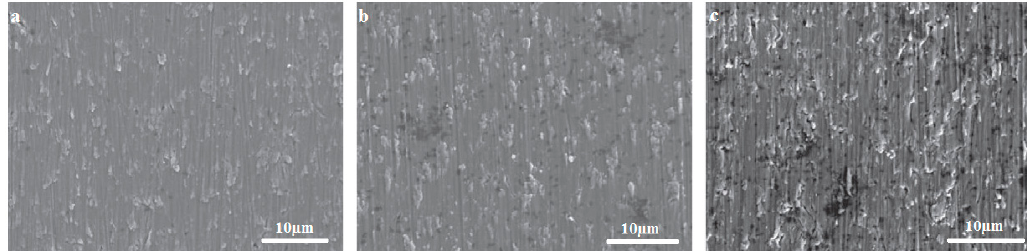
Figure 1. Scanning electron microscope (SEM) images of Ti-24Nb-4Zr-8Sn alloy after immersion in 0.9% NaCl solution at 37 °C for: ( a ) 24 h, ( b ) 72 h, and ( c ) 168 h [43].